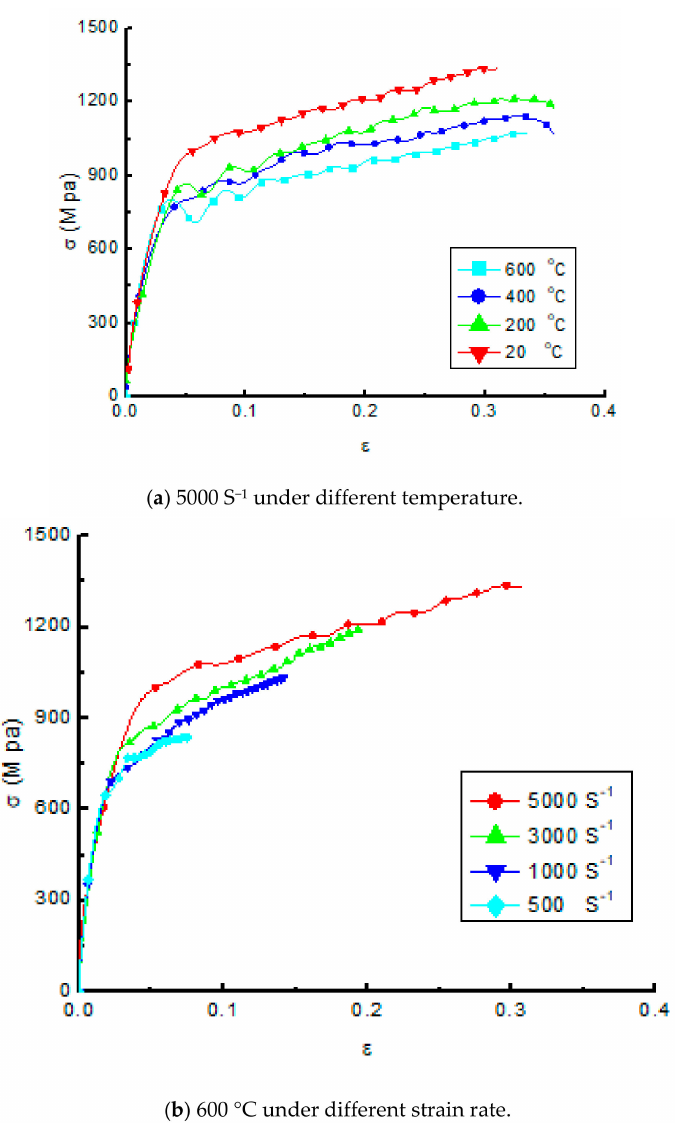
Figure 4. Stress–strain curves of gray cast